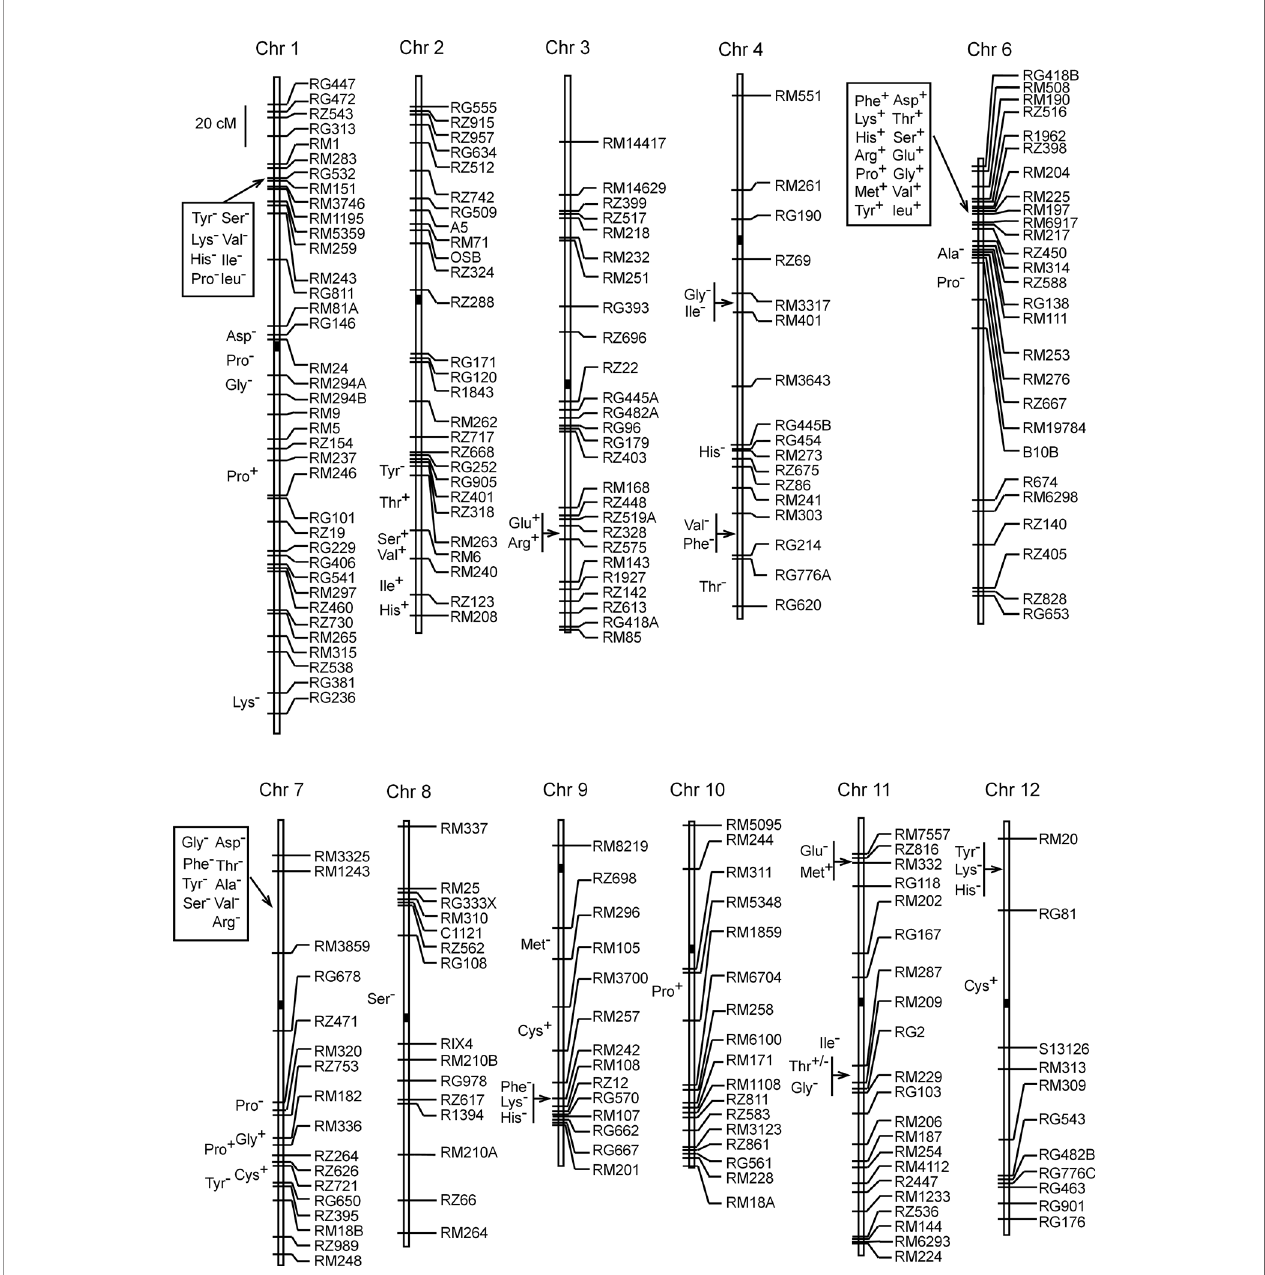
FIGURE 1 | Chromosomal locations of quantitative trait loci for 17 components of amino acid contents detected in the recombinant inbred line population of Zhenshan 97/Milyang